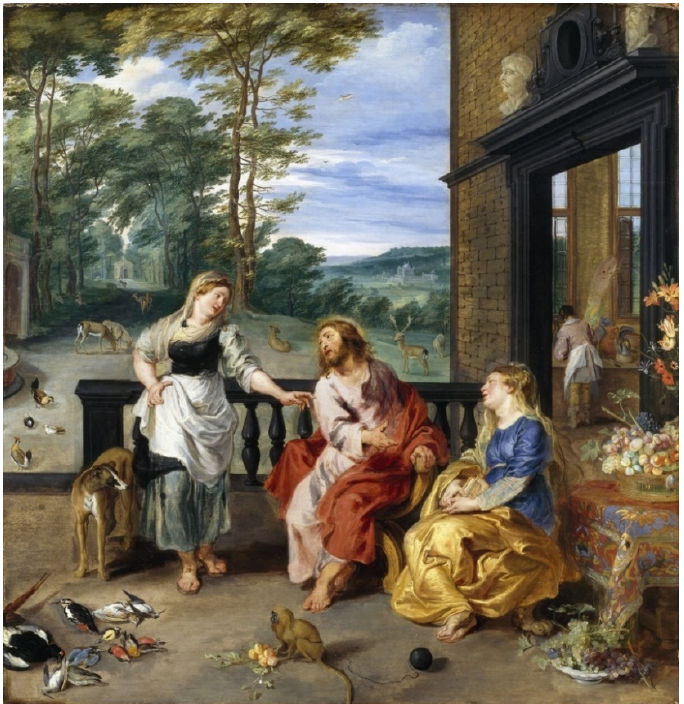
Figure 1. Peter Paul Rubens, Jan Brueghel II, Christ in the House of Martha and Mary , c. 1628, oil on oak panel, 64 × 61.9 cm. National Gallery of Ireland. Dublin Credit line: Wikimedia Commons.